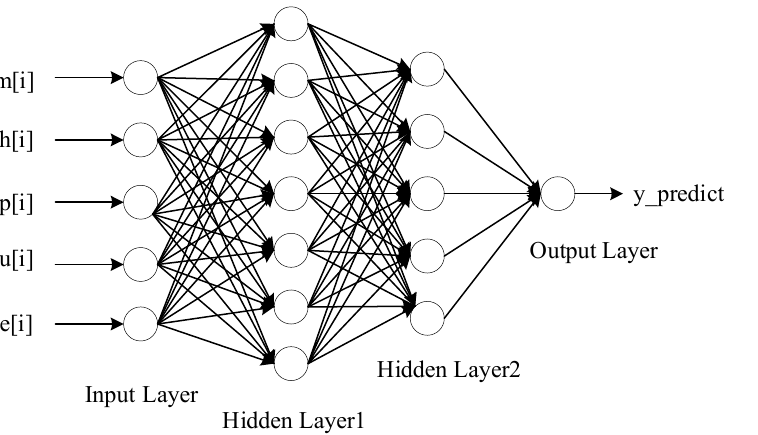
Figure 11. Architecture of the BPNN prediction model coupled with spatiotemporal characteristics.